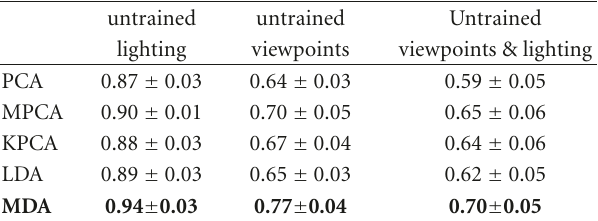
Figure 6: The first two coordinates of lighting feature vectors computed by Multifactor Discriminant Analysis using the Extended Yale database. Table 1: Rank-1 recognition rate on the Extended YaleB